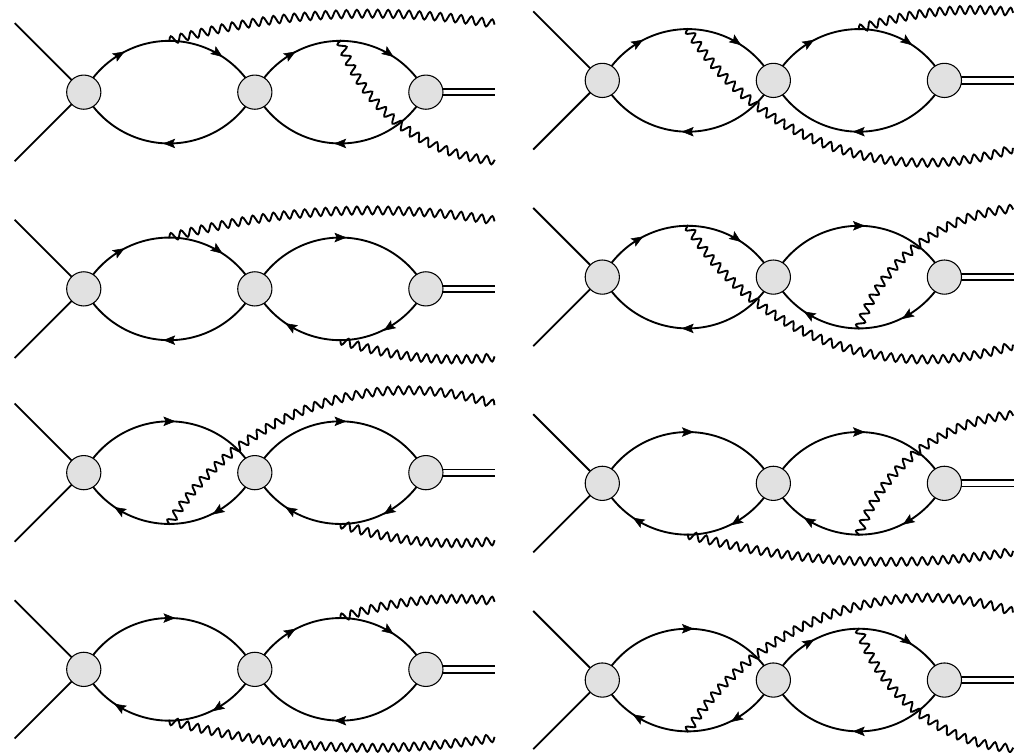
Figure 22 . Diagrams for w 0 w 0 ! ( ww ) + (cid:13)(cid:13) in which the two photons are attached to charged- wino lines in separate loops. The sum of the two diagrams in which a photon is attached to a w + line and a w (cid:0) from the same bubble is